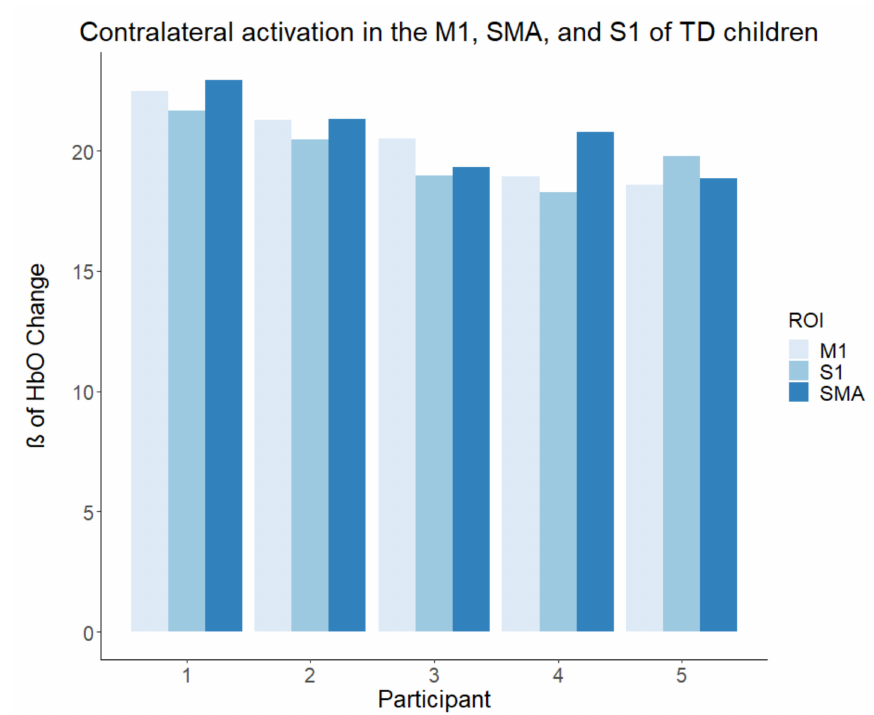
Figure 4. Activation in the TD group using the prosthetic simulator. Beta (ß) values produced by the GLM are used as markers of activation with the brain, indicating that the activation matched the expected canonical hemodynamic response. All TD participants demonstrated higher motor activity compared to the ULR